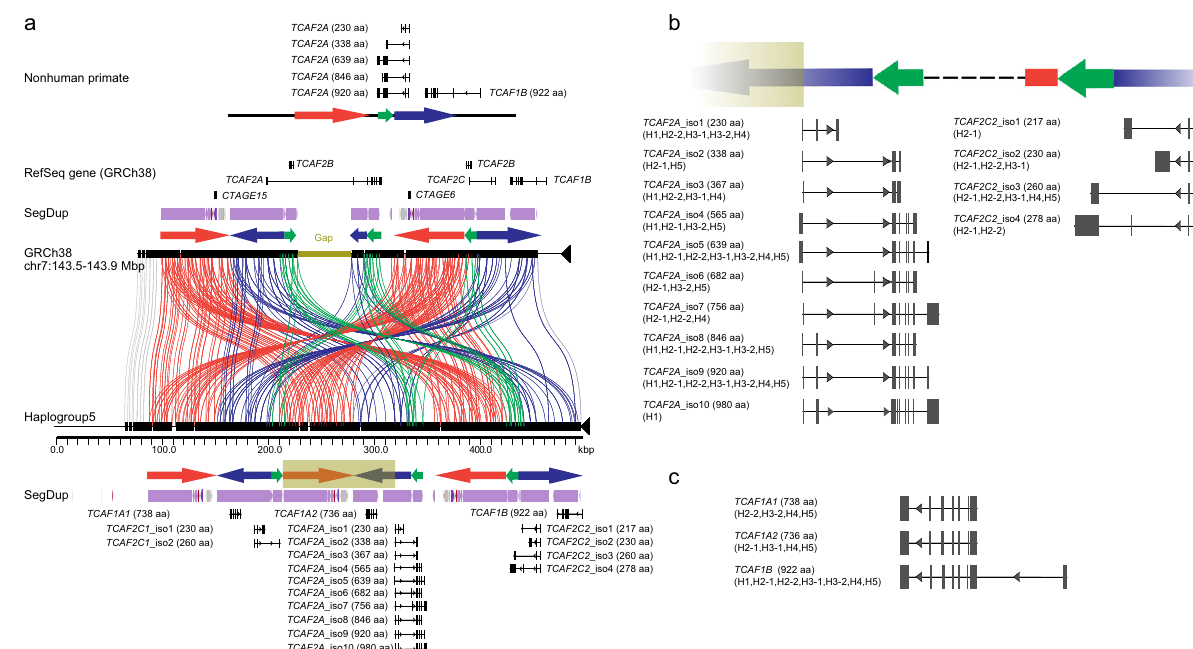
Fig. 3 TCAF gene and isoform diversity among human haplotypes. a Miropeats analysis reveals great consistency between Haplogroup 5 and the gapped 7q35 TCAF locus in the human reference genome (GRCh38). Colored arrows are annotated TCAF SDs and lines connecting the sequences show regions of homology. The dark green rectangle in the sequence-resolved, gap-free Haplogroup 5 contig (bottom) represents the region missing in the GRCh38 sequence (dark green bar, top). Additional annotations include a schematic of TCAF sequence structure and gene models/isoforms for nonhuman primate, RefSeq gene track (GRCh38), segmental duplication (SegDup) tracks, and predicted TCAF models and isoforms using full-length non-chimeric transcripts from six human tissues (Methods). Note that the TCAF2A gene model in GRCh38 is incorrect due to the presence of the gap in the middle of the TCAF SD region. For illustration, all predicted gene models and isoforms are aligned to Haplogroup 5 sequence for b TCAF2A and c TCAF2C , along with annotations for amino acid (aa) sequence lengths and haplogroups in which they are observed. For simplicity, we skip sequences between TCAF2A and TCAF2C2 (dashed line). Detailed haplotype-speci fi c and/or tissue-speci fi c gene models and isoforms can be found in Supplementary Figs. 6 – 13 and Supplementary Data